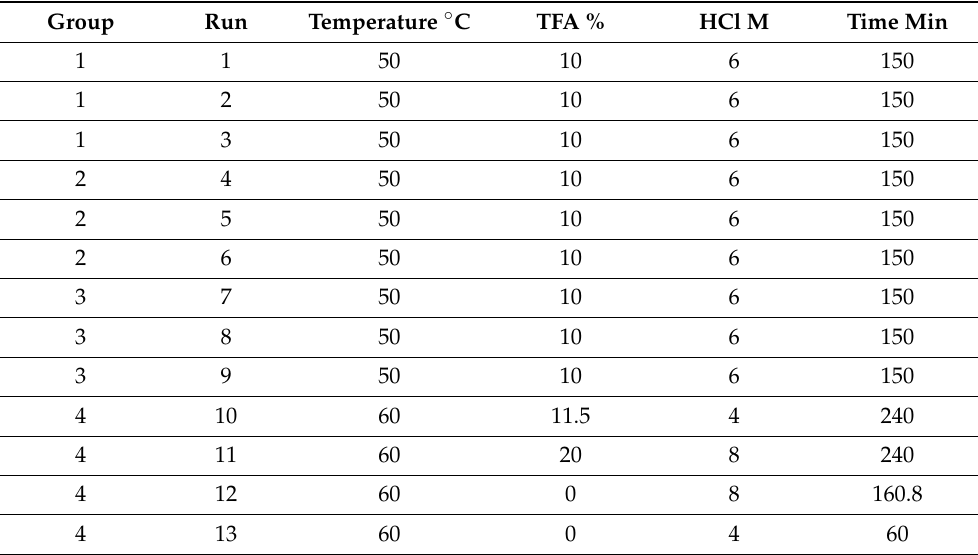
Table A2. Sample preparation and DoE runs for HPAEC-PAD